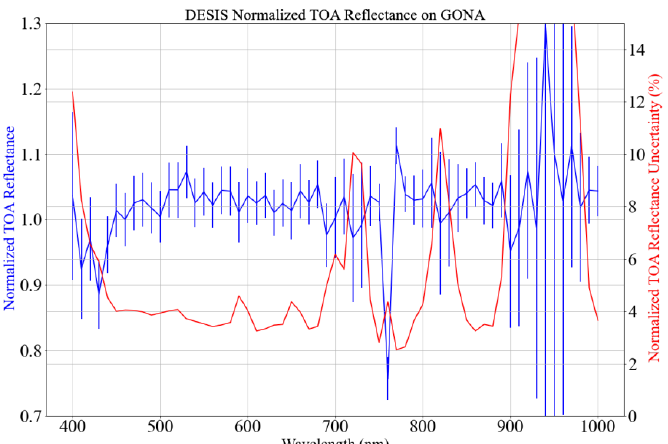
Figure 12. Mean and standard deviation of 15 normalized DESIS TOA reflectance shown in Figure 11a.